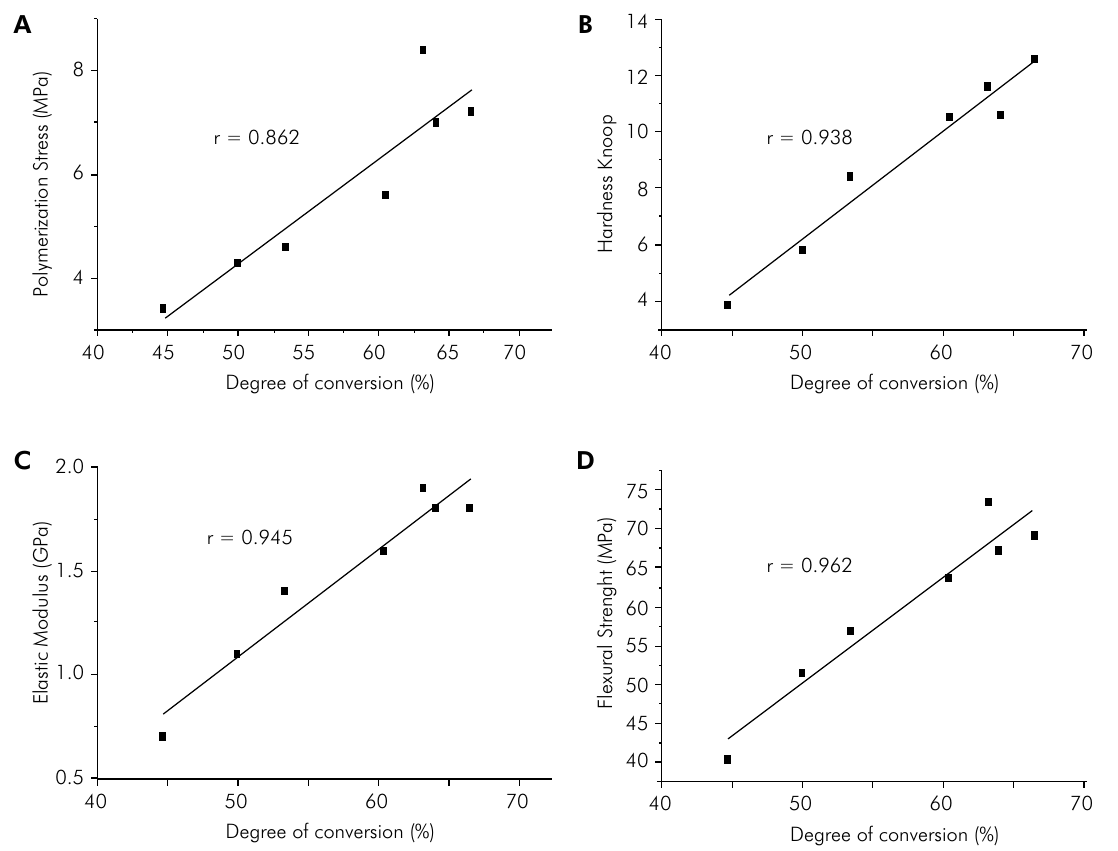
Figure 1. Analysis of the linear correlation between polymerization stress (A), Knoop hardness (B), elastic modulus (C), flexural strength (D), and degree of